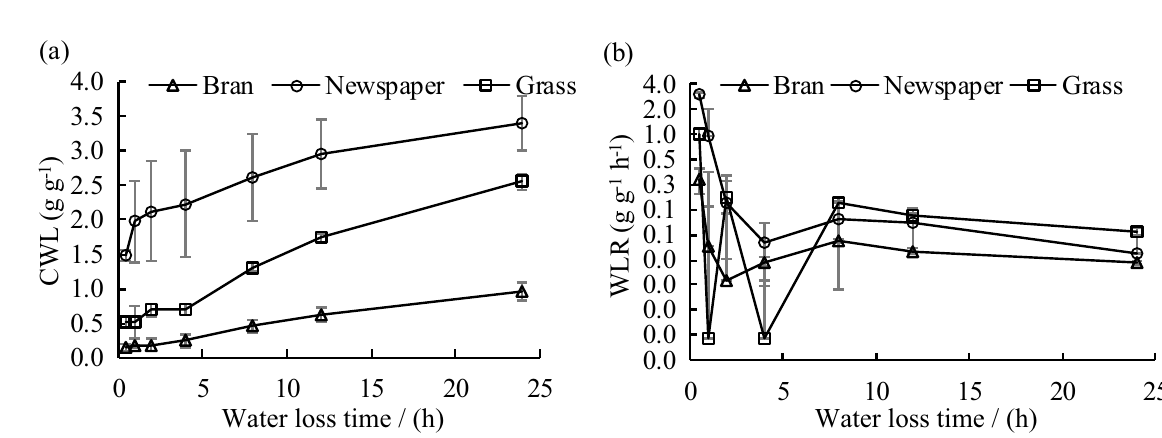
Figure 4. Cumulative water loss (CWL a ) and water loss rate (WLR b ) of different organic